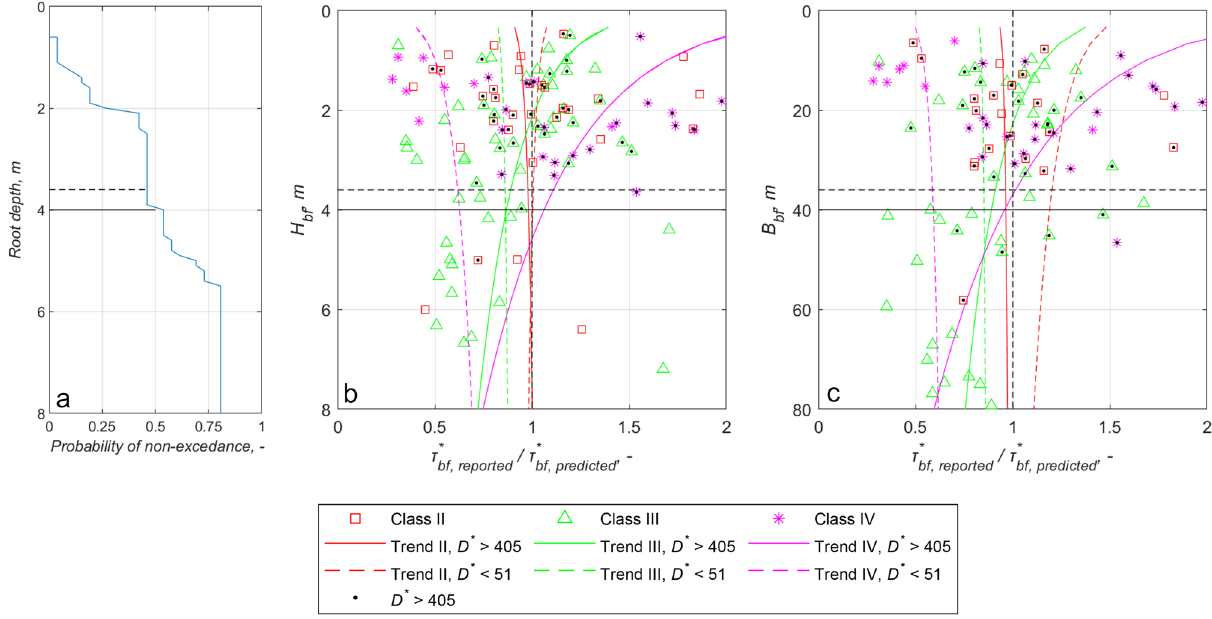
Figure 3. ( a ) Probability of non-exceedance of root deth as a function of depth below surface. ( b , c ) Trend analysis of correction ratios τ bf *, reported /τ bf *, predicted as functions of bankfull depth (H bf ) ( b ) and bankfull width (B bf ) ( c ), respectively. Continuous horizontal black line shows the most probable root layer ( H root _ median = 4.0m ) in ( a , b ) and 10 H root _ median in ( c ). Dashed horizontal black line shows the mean root layer ( H root _ mean = 3.6m ) in ( a , b ) and 10 H root _ mean in ( c ).The data are discriminated according to vegetation class and bed material. The colors and symbols refer to the riparian vegetation density: red square—Class II, green triangle—Class III and pink star—Class IV (the densest vegetation cover). Granular ( D ∗ > ~ 405) bank material are denoted by a black dot in the symbol, while the symbols for finer soils ( D ∗ < ~ 51; D < ~ 2 mm) are unfilled. The coloring order of the fitted curves is the same as that of the symbols. The solid lines represents the granular ( D ∗ > ~ 405; D > ~ 16 mm) sediment, while the dashed lines represent the finer sediment ( D ∗ < ~ 51). We did not display Class 1 in the figure because there was no depth dependent trend (which is to be expected due to the lack of